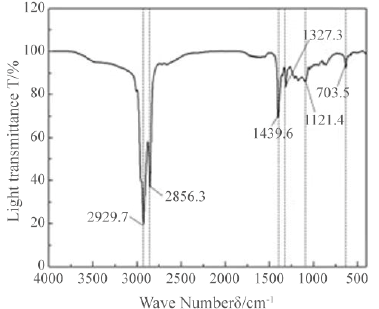
Figure 7. IR spectrum of REOB.